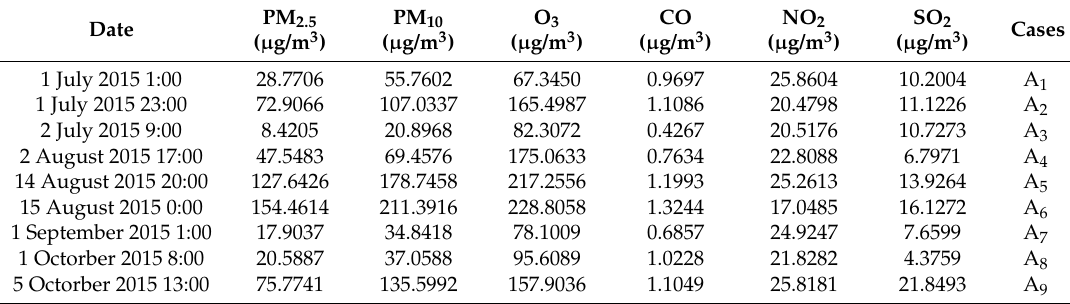
Table 13. The forecasting samples from test subset used for